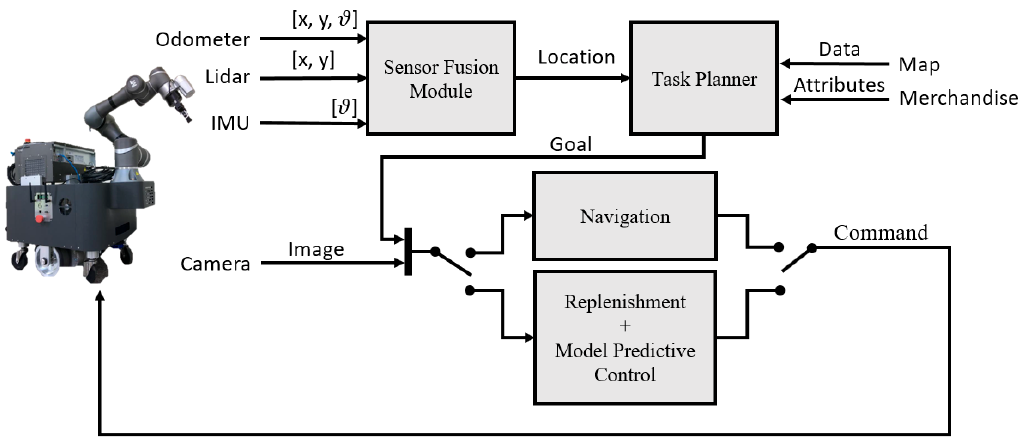
Figure 1. A conceptual diagram for the proposed autonomous replenishment system.